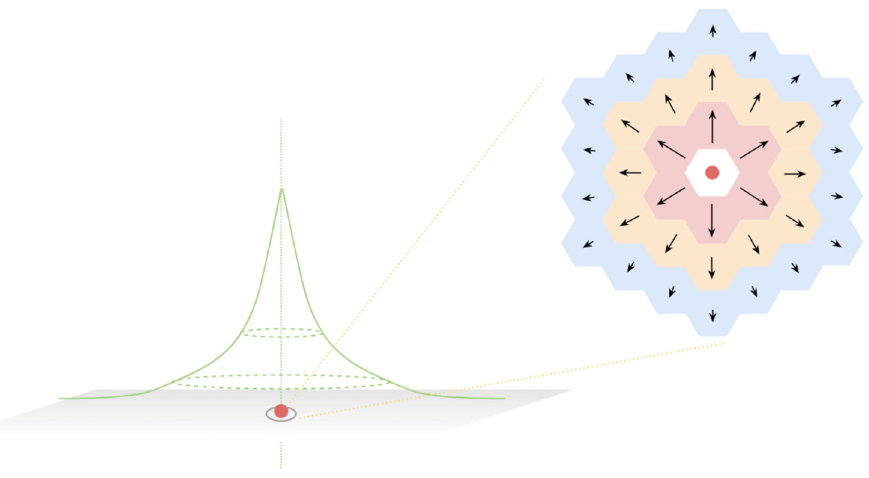
Figure 4. ( Left ) An activity location (red point) and its vector field. The green cone represents the vector modulus values in all positions, and these values attenuate in all directions, following the trend of the probability density function curve. ( Right ) Top view of the red point. The shift in color from red to blue represents the vector modulus decreasing from high to low. Arrows represent vectors, and the length and direction of each arrow show the modulus and directions of the vector it represents. The vectors are projected onto the cell center to form the vector field.